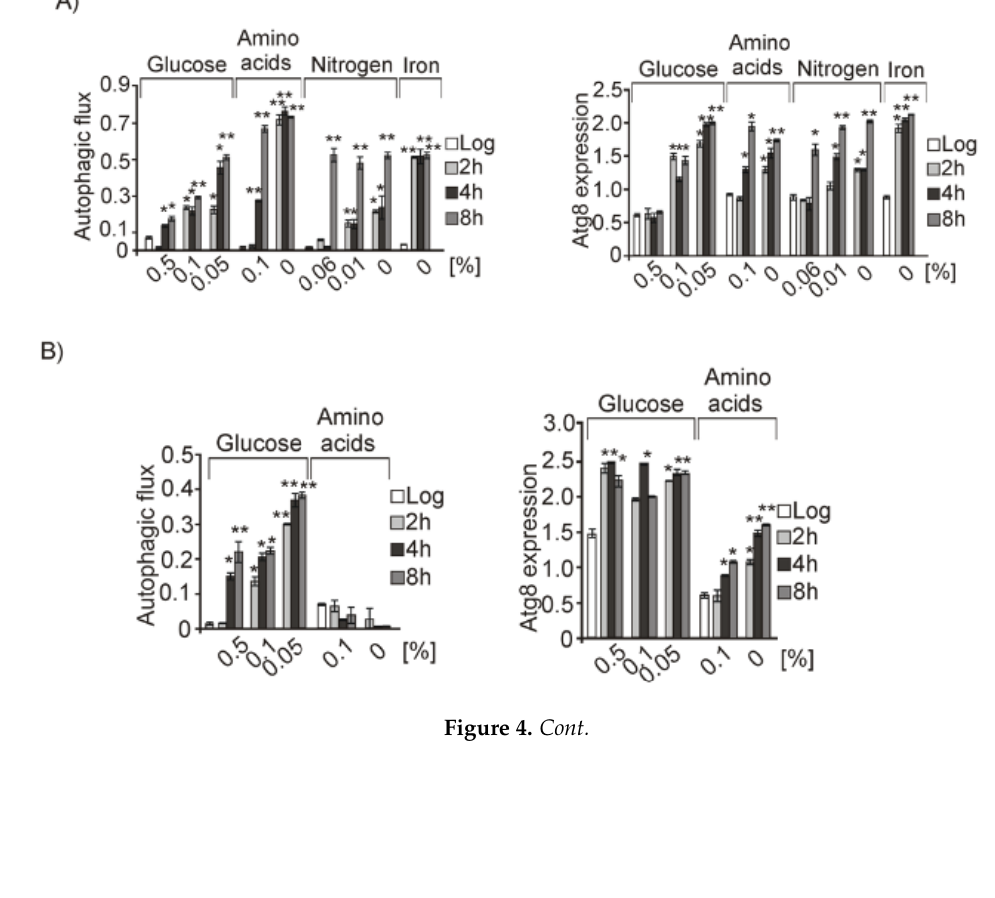
Figure 4. Mtl1 signals glucose limitation to autophagy machinery. ( A ) wt cells expressing GFP – Atg8 were exponentially grown in SD media. Aliquots were taken, washed, and transferred to different minimum media containing: 0.5, 0.1, or 0.05% glucose; 0.1 or 0% amino acids; 0.06, 0.01, or 0% nitrogen or medium without iron (0%). Autophagic flux and Atg8 expression were determined as in Figure 1B. The same experiments as in A were carried out in ( B ) gcn2 mutant cultures expressing GFP – Atg8 and in a ( C ) mtl1 strain expressing GFP – Atg8. ( D ) Atg1HA protein was identified by Western blot using anti-HA antibody, as in Figure 1A. Error bars in the histograms represent the standard deviation (SD) calculated from three independent experiments. Significance of the data was determinate by p- values from a Student’s unpaired t - test denoted as follows: * = 0.05  p  0.01; ** = 0.01  p  0.001; *** = 0.001  p  0.0001. However, placing cells at 0% glucose, we did not observe free GFP in either the West- ern blot or accumulated in vacuoles. Hence, bulk autophagy was not induced in wt or